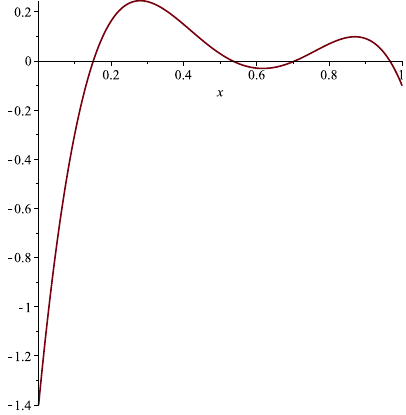
Figure 6. The approximate solution of u 2 ( x ) for Example